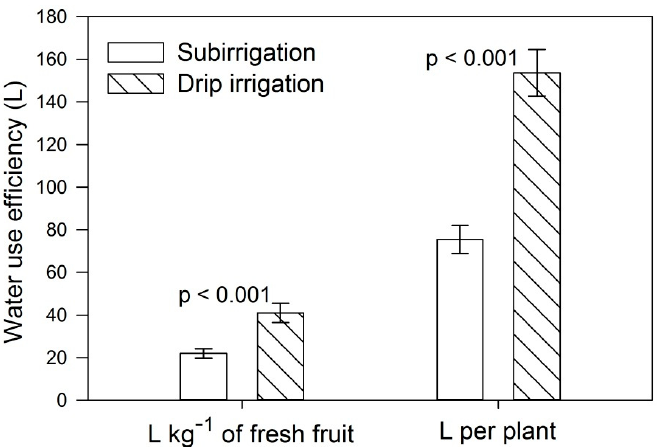
Figure 3. Water use efficiency in terms of fresh fruit production and total evapotranspirated water in containerized tomato ( Solanum lycopersicon L.) plants grown in two irrigation systems. Means were significantly different according to ANOVA.